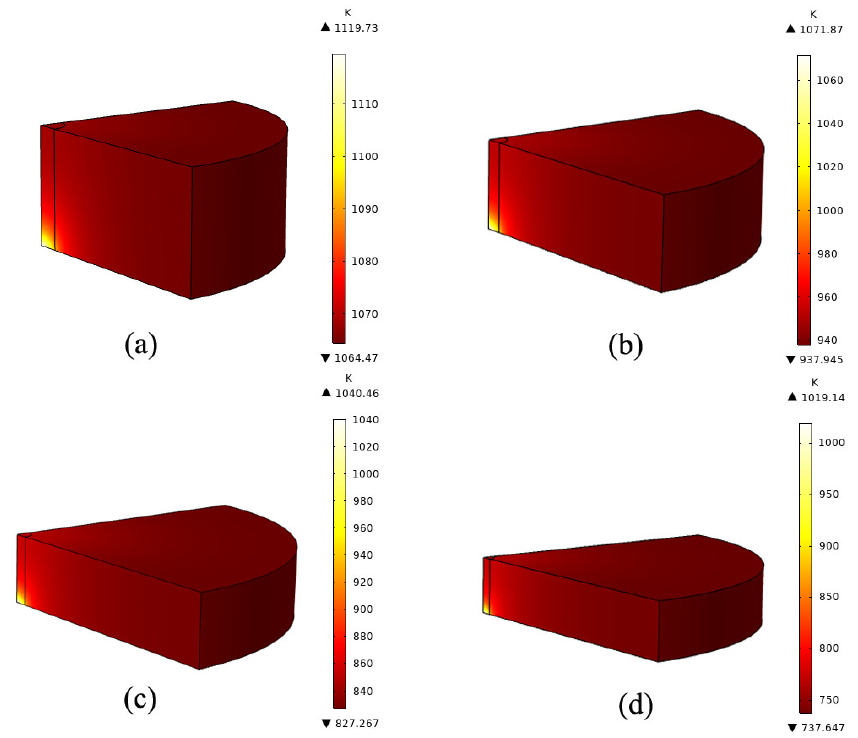
Figure 4. ( a – d ) are the temperature change in the center of silicon wafers with different radii (10 mm, 15 mm, 20 mm, 25 mm) at the end of 60 s continuous laser beam irradiation, respectively. 15 mm, 20 mm, 25 mm) at the end of 60 s continuous laser beam irradiation,